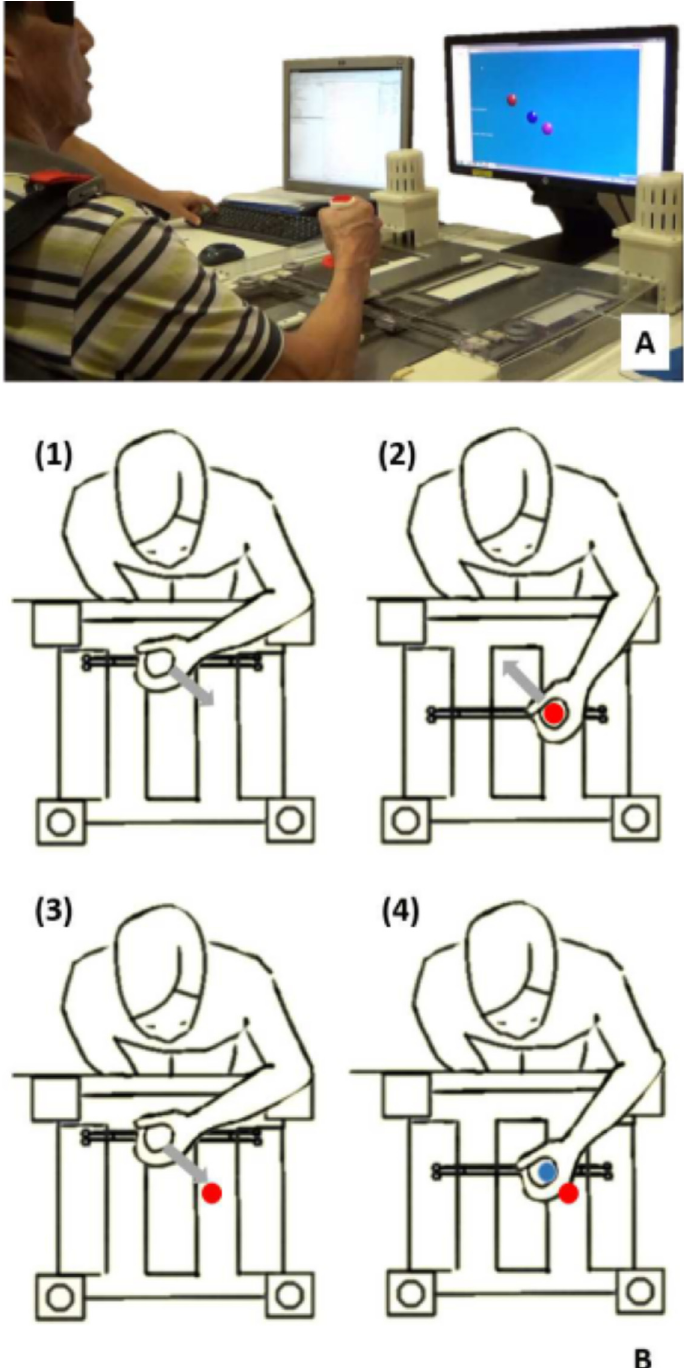
Fig 1. Apparatus and procedure. (A) Participant(blindfolded) holdingthe handleof H-Man, the robotic device employedin the study. (B) Experimental procedure: starting from the initial position (1), H-Man placed the handleon the target positionand held it there for 2 seconds (2), after which the handlewas returnedto the initial positionto start the new movement towards the same target (3), which was stoppedvia a hand-held button by the investigatorwhen the participantverbally indicatedthat the positionof the handlematched the target (4). The handlewas then returnedto the initial positionfor the followingtrial.